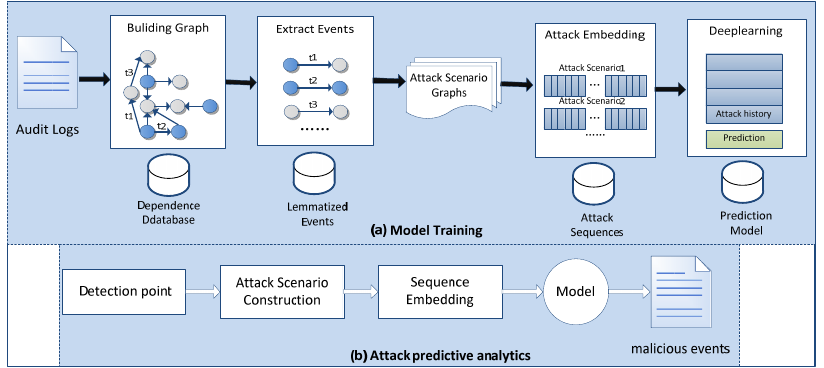
Figure 2. Overview of proposed architecture.